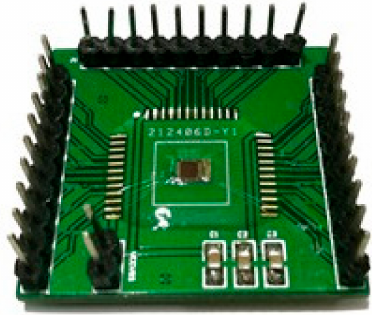
Figure 15. Testing chip and printed-circuit-board